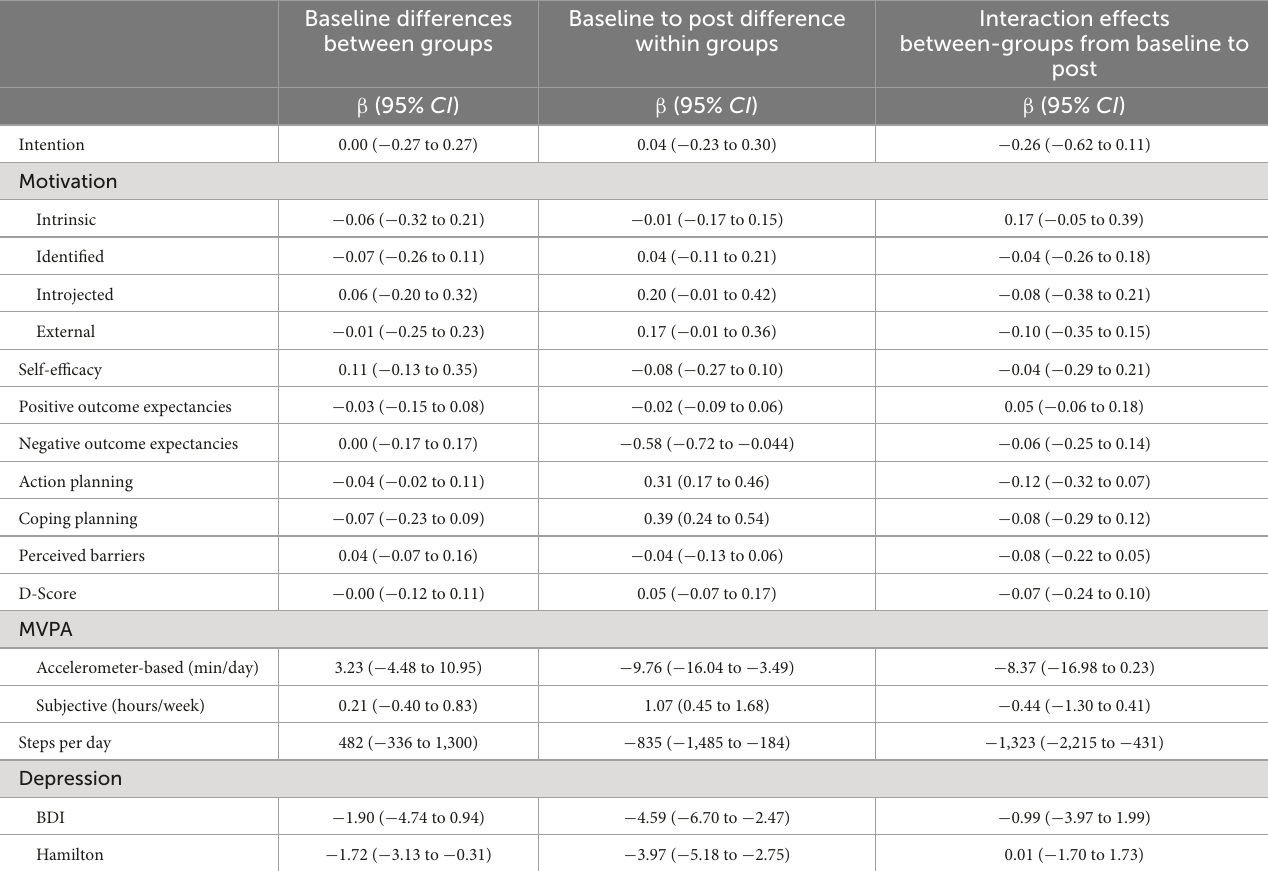
TABLE 3 Group differences over time in main variables.